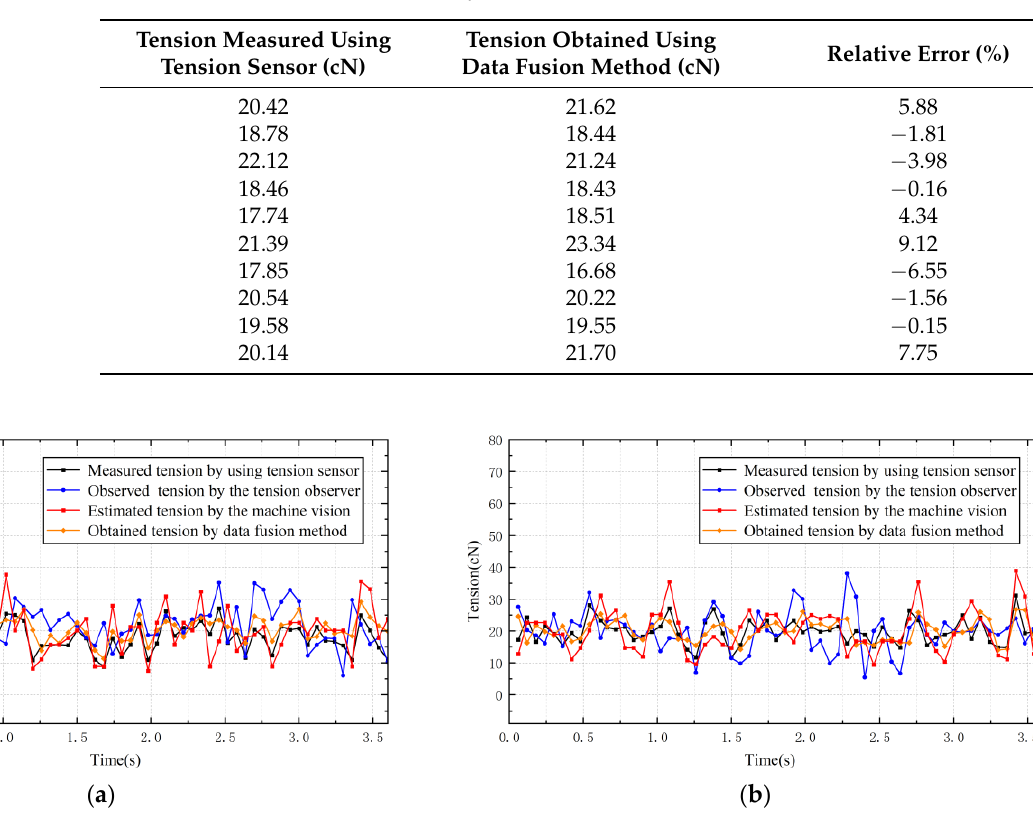
Figure 18. Data fusion experiments. ( a ) The sampling period is 0.06 s. ( b ) The sampling period is 0.07 s.